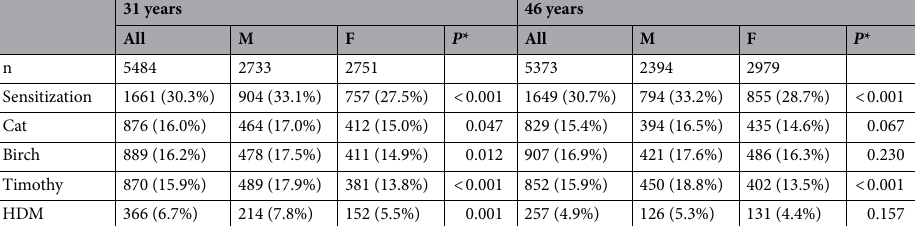
Table 4. Prevalence of sensitization at 31-year and 46-year studies by sex. HDM house dust mite. * P value for difference between sexes.